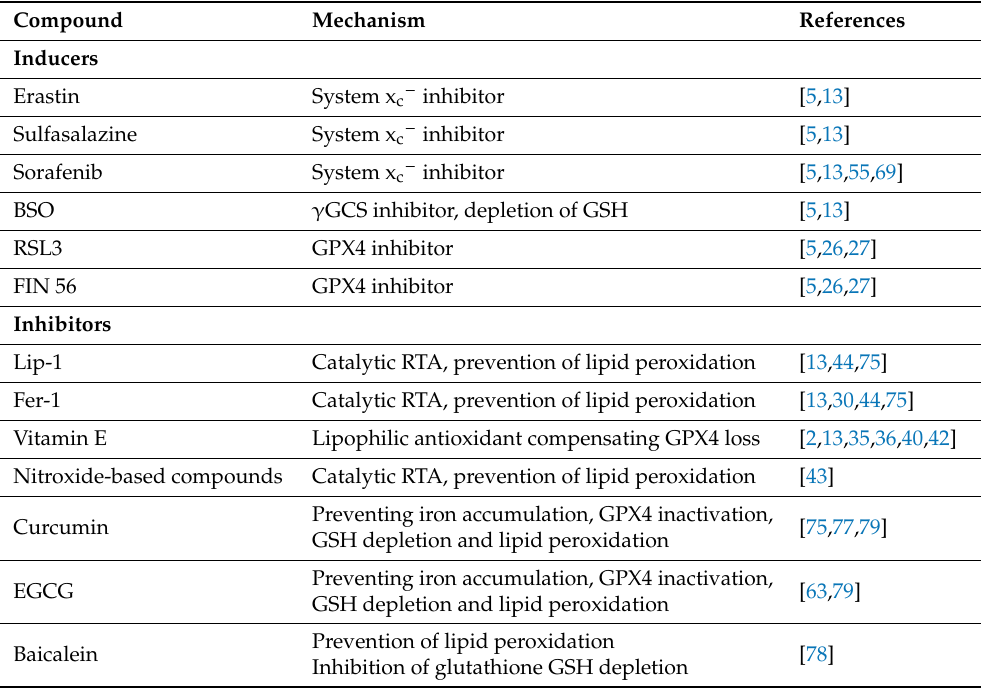
Table 1. A summary of some inducers and inhibitors of